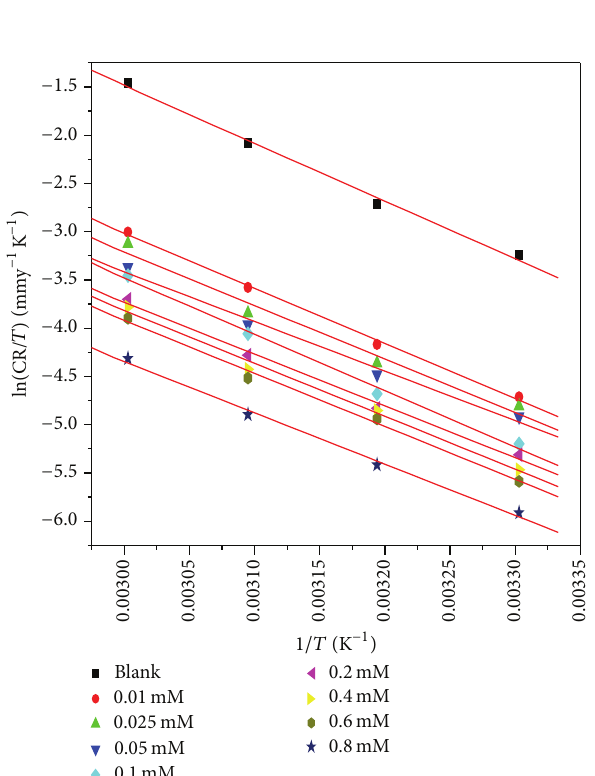
Figure 4: Plot of ln ( CR /𝑇) versus 1/ T for mild steel specimen in 1M HCl containing various concentrations of HIBH.